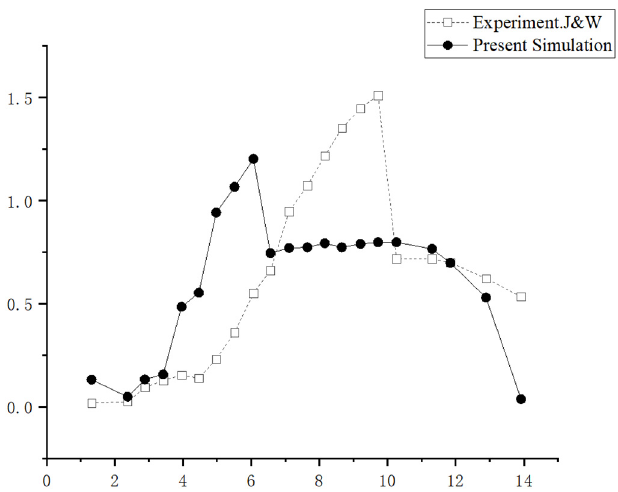
Figure 6. The trajectory of the cylindrical oscillator at different reduced velocities.